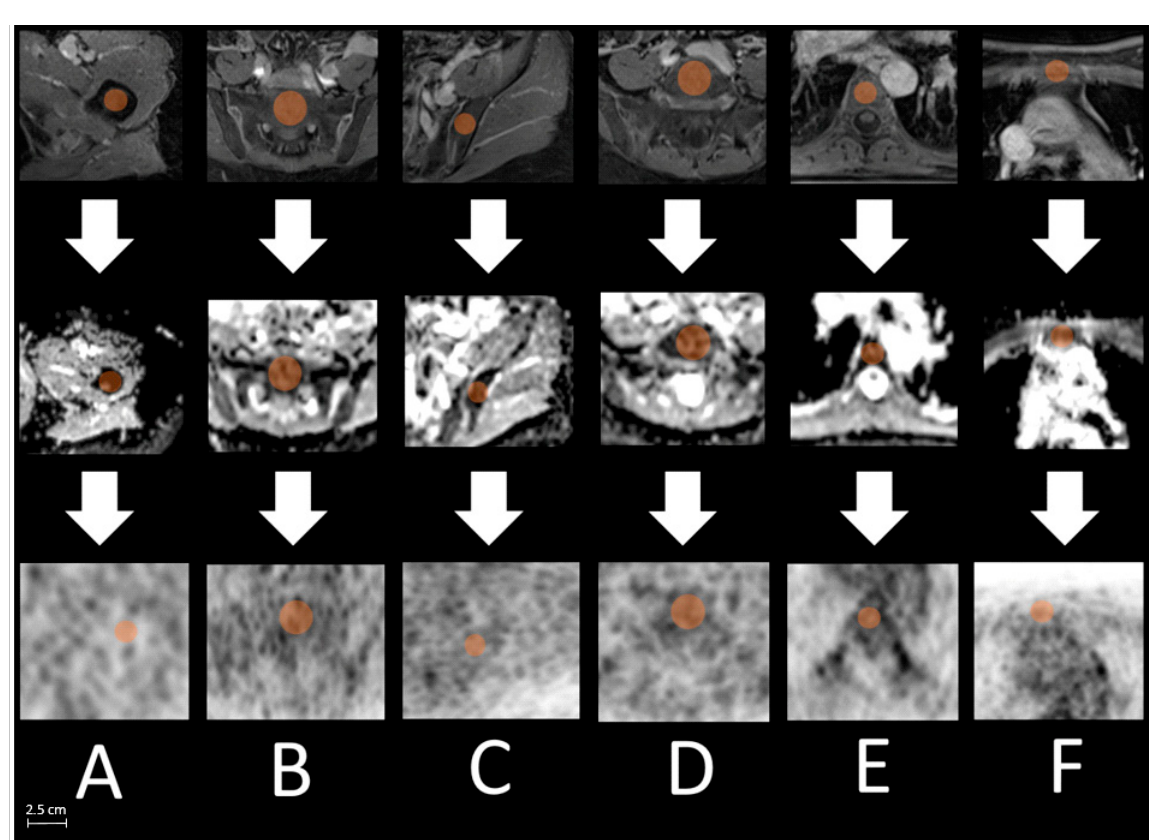
Figure 2. Exemplified measurement processes with locating defined bone regions (( A ): right femur, ( B ): os sacrum, ( C ): os ilium, ( D ): L 5, ( E ): T 7, ( F ): sternum) in T1 weighted post-contrast sequence (upper row), pacing a bone size adapted volume of interest (VOI, orange, max. 2.5 cm os sacrum) centrally in each bone location in the ADC map (middle row) and afterward copying the VOI to the corresponding slice of the PET images (lower row).